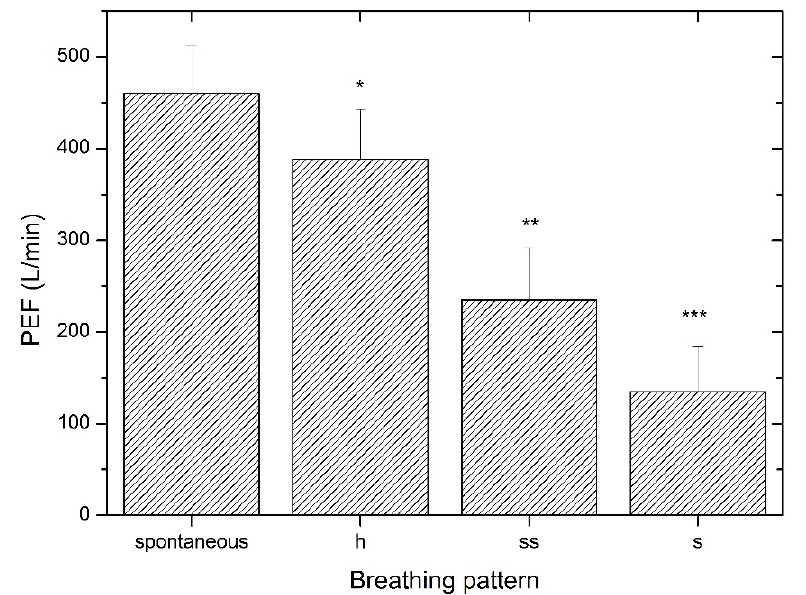
Figure 1. PEF at different breathing patterns. PEF—peak expiratory flow; spontaneous—spontaneous exhalation; h—phonated exhalation pronouncing “h”; s—phonated exhalation pronouncing “s”; ss—phonated exhalation pronouncing “ss”; *—significantly different compared to spontaneous breathing, ss and s; **—significantly different compared to h, s and spontaneous breathing; ***— significantly different compared to h, ss and spontaneous breathing. p < 0.05.